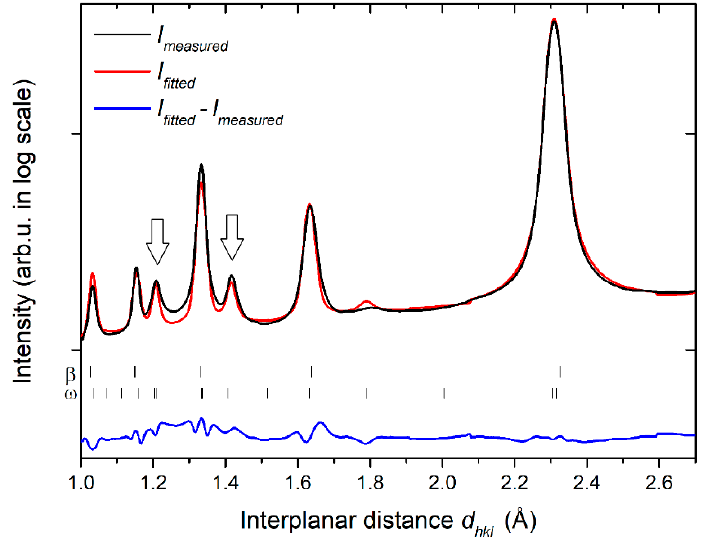
Figure 8. High-energy synchrotron X-ray diffraction (HEXRD) pattern of the HPT-deformed sample. The XRD pattern of the HPT deformed specimen exhibits significantly broadened peaks due